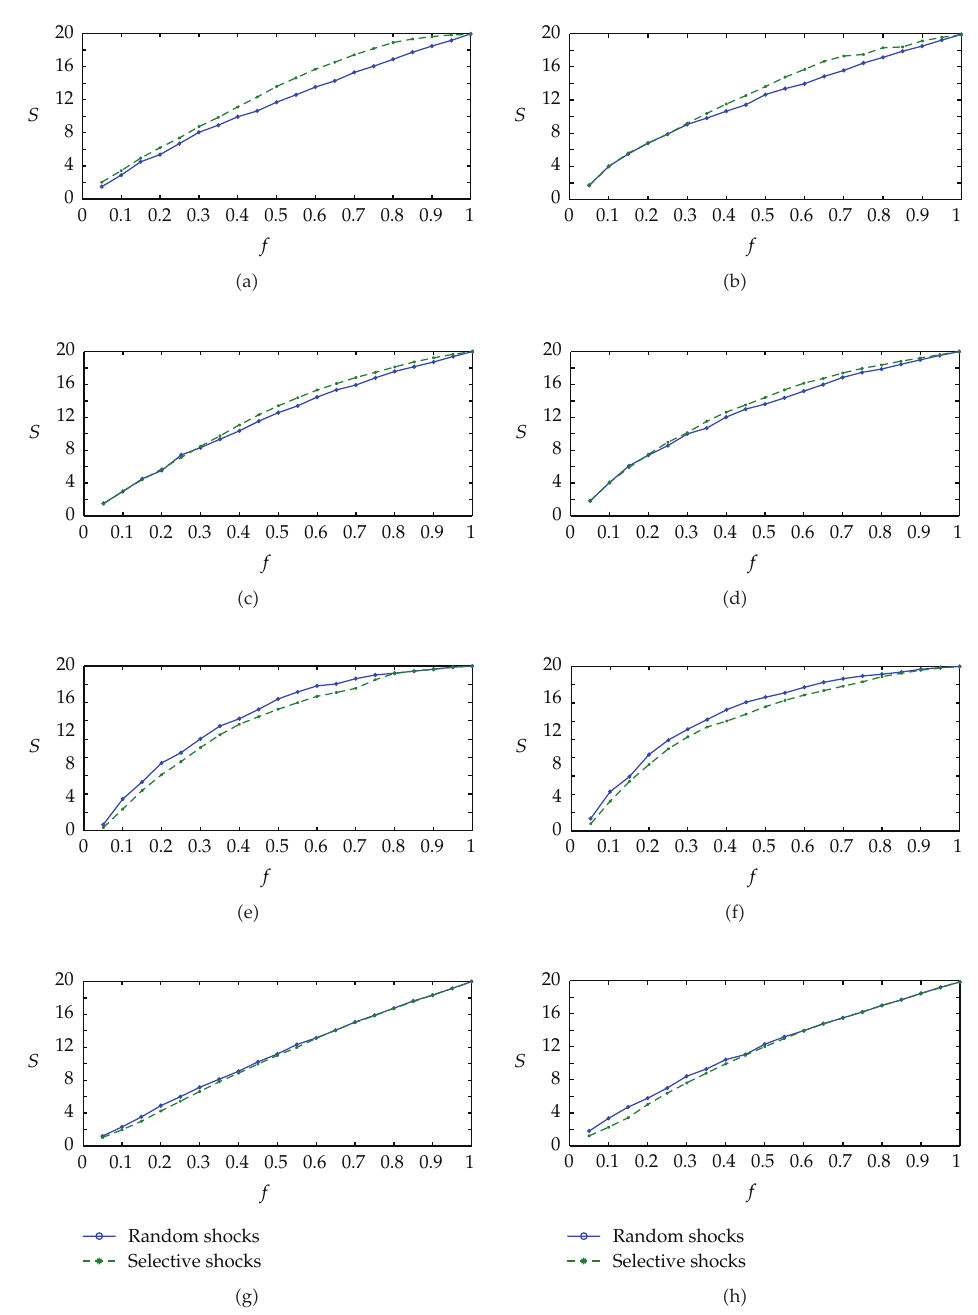
Figure 2: Number of defaults caused by random shocks and selective shocks. (cid:5) a (cid:6) , (cid:5) c (cid:6) , (cid:5) e (cid:6) , and (cid:5) g (cid:6) correspond respectively to the results of tiered networks, random networks, small-world networks, and scale-free networks in the homogeneous case; (cid:5) b (cid:6) , (cid:5) d (cid:6) , (cid:5) f (cid:6) , and (cid:5) h (cid:6) are, respectively, the results of tiered networks, random networks, small-world networks, and scale-free networks in the heterogeneous case. f denotes the number of shocked banks in the interbank market, and S represents the number of